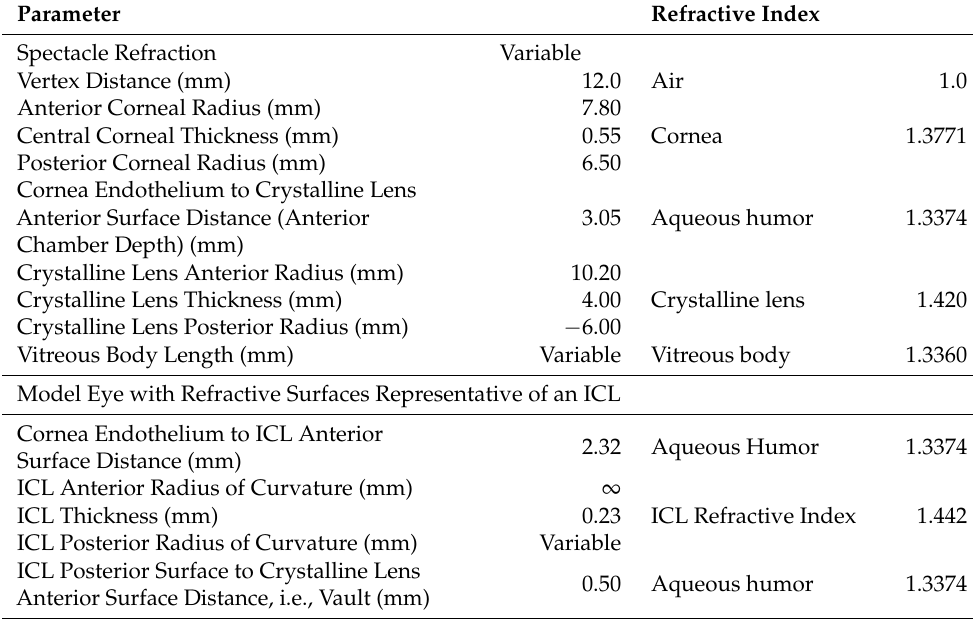
Table 1. Le Grand full theoretical model eye